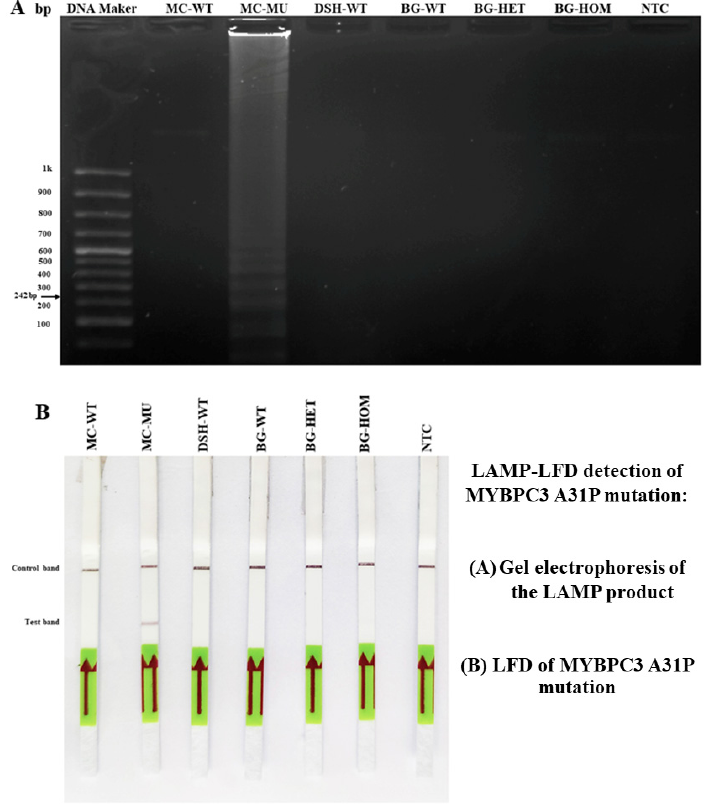
Figure 3. The results of LAMP-LFD detection of MYBPC3-A31P mutation in the study animals. ( A ) The determination of the LAMP product was based on the analysis of gel electrophoresis at 242 bp. ( B ) LFD of MYBPC3-A31P mutation. MC = Maine coon cat; DSH = Domestic short hair; BG = Bengal cat; WT = wild-type; MU = mutant; HET = heterozygous mutation; HOM = homozygous mutation; NTC = negative control; bp = base pair.